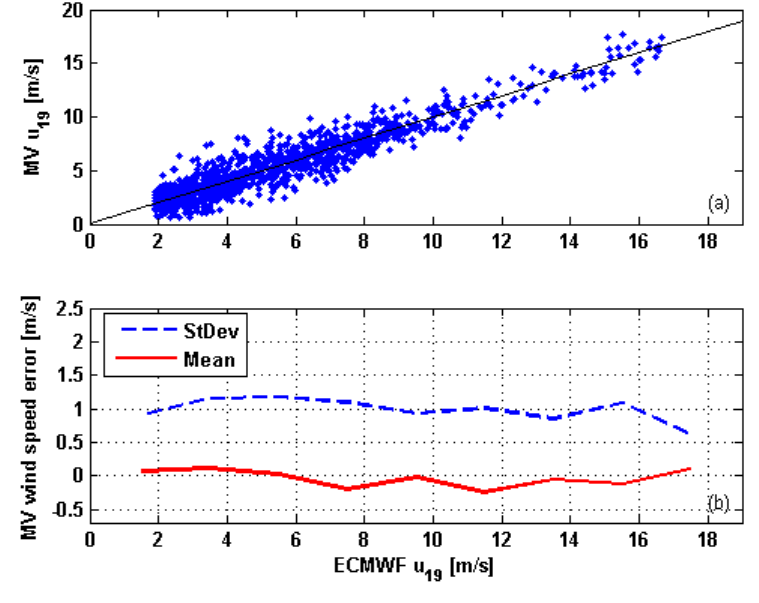
Figure 6 . Estimated versus ECMWF wind velocities (a), and binned analysis of the mean (solid red line) and of the standard deviation (dashed blue line) of the black solid line indicates perfect agreement. Both panels concern